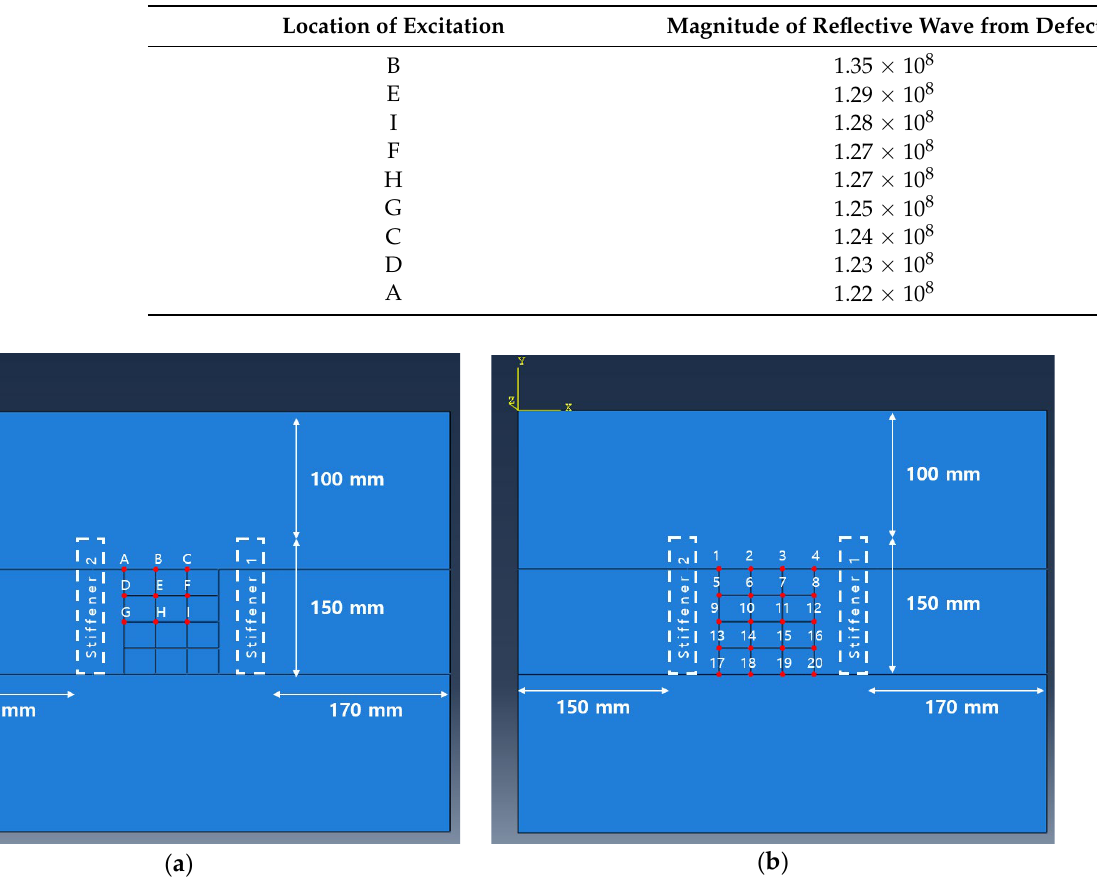
Figure 10. ( a ) Candidate excitation locations on aluminum panel with stiffener; ( b ) sensor locations on aluminum panel with stiffener.